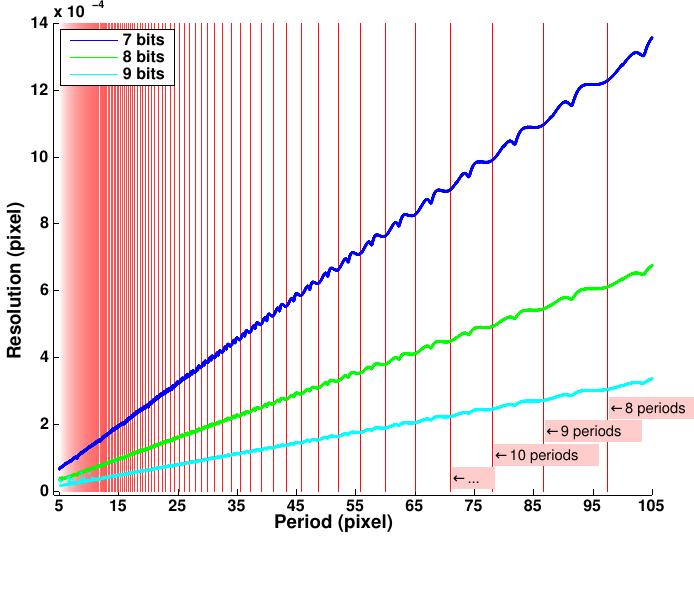
Figure 8. Ultimate resolution in pixels as a function of grid period and quantization depth (At each period, maximum error observed on 10 3 positions shifted by 10 − 6 pixel).